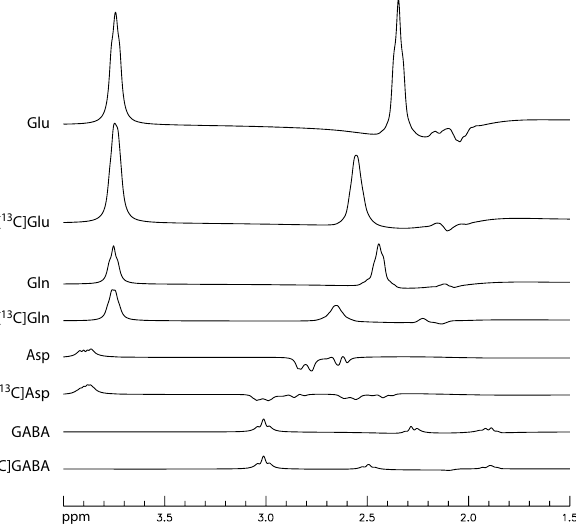
Figure 1. Numerically simulated spectra of Glu, 13 C satellites of Glu ([ 13 C]Glu), Gln, 13 C satellites of Gln ([ 13 C] Gln), Asp, 13 C satellites of Asp ([ 13 C]Asp), GABA, and 13 C satellites of GABA ([ 13 C]GABA) at TE = 56 ms. The corresponding concentration ratios were set to 10:10:3:3:3:3:1:1. The spectra were broadened to a singlet width of 8